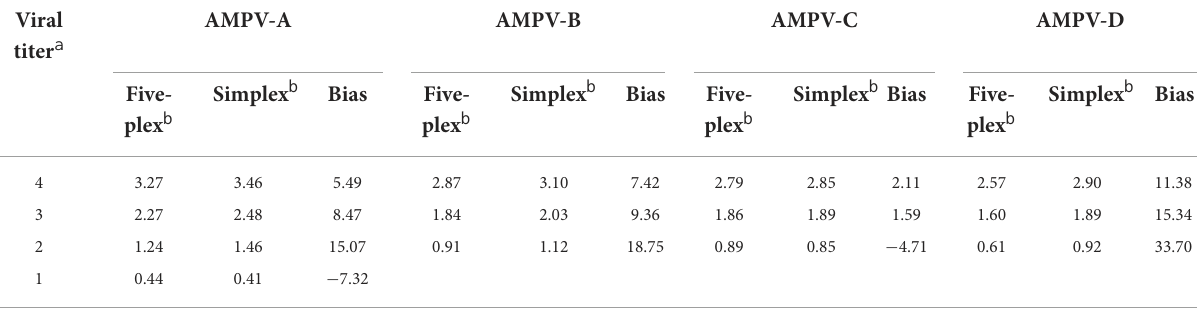
TABLE 3 Comparison between five-plex and simplex RT-ddPCR.